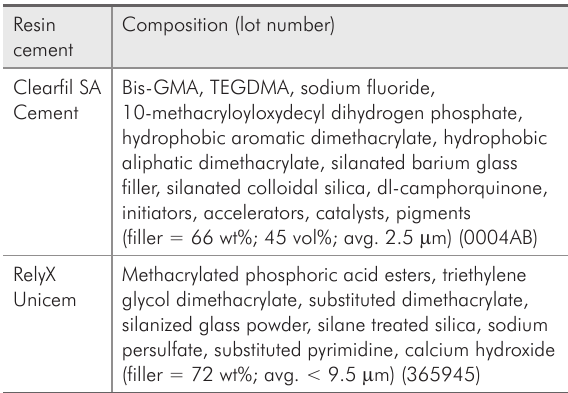
Table 1 - Composition and lot number of the materials tested in this